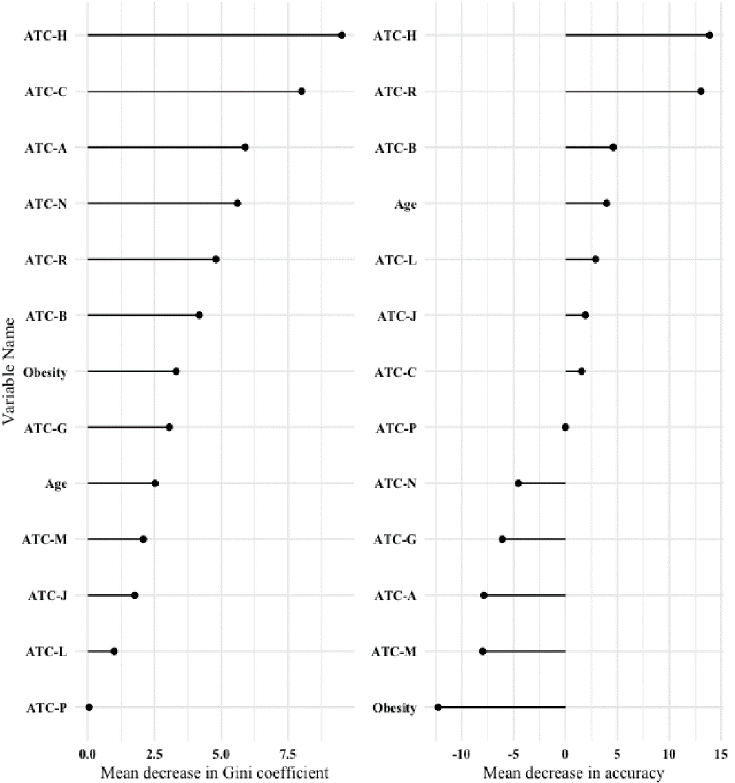
Figure 3. Variable importance plot after a random forest classification algorithm. Left panel: Mean decrease in Gini coefficient (a measure of how each variable contributes to the homogeneity of the nodes and leaves in the resulting random forest); Right panel: Mean decrease in accuracy (a measure of how much accuracy the model loses by excluding each variable). The higher the value of mean decrease in accuracy or mean decrease in Gini score, the higher the importance of the variable in the model. ATC-A = number of preoperative ATC classification code A medications—alimentary tract and metabolism; ATC-B = number of preoperative ATC classification code B medications—blood and blood-forming organs; ATC-C = number of preoperative ATC classification code C medica- tions—cardiovascular system; ATC-G = number of preoperative ATC classification code G medica- tions—genito-urinary system and sex hormones; ATC-H = number of preoperative ATC classifica- tion code H medications—systemic hormonal preparations, excluding sex hormones and insulins; ATC-J = number of preoperative ATC classification code J medications—anti-infectives for systemic use; ATC-L = number of preoperative ATC classification code L medications—antineoplastic and immunomodulating agents; ATC-M = number of preoperative ATC classification code M medica- tions—musculo-skeletal system; ATC-N = number of preoperative ATC classification code N med- ications—nervous system; ATC-P = number of preoperative ATC classification code P medica- tions—antiparasitic products, insecticides and repellents; ATC-R = number of preoperative ATC classification code R medications—respiratory system. 4. Discussion Preoperative treatment with systemic hormones (ATC-H drugs) is associated with an increased risk of a longer postoperative stay after transsphenoidal pituitary surgery. Postoperative CSF leakage and diabetes insipidus were the most frequently encountered complications among patients with pPOLOS. This is in accordance with the reports of Lobatto et al. in their systematic review [21].